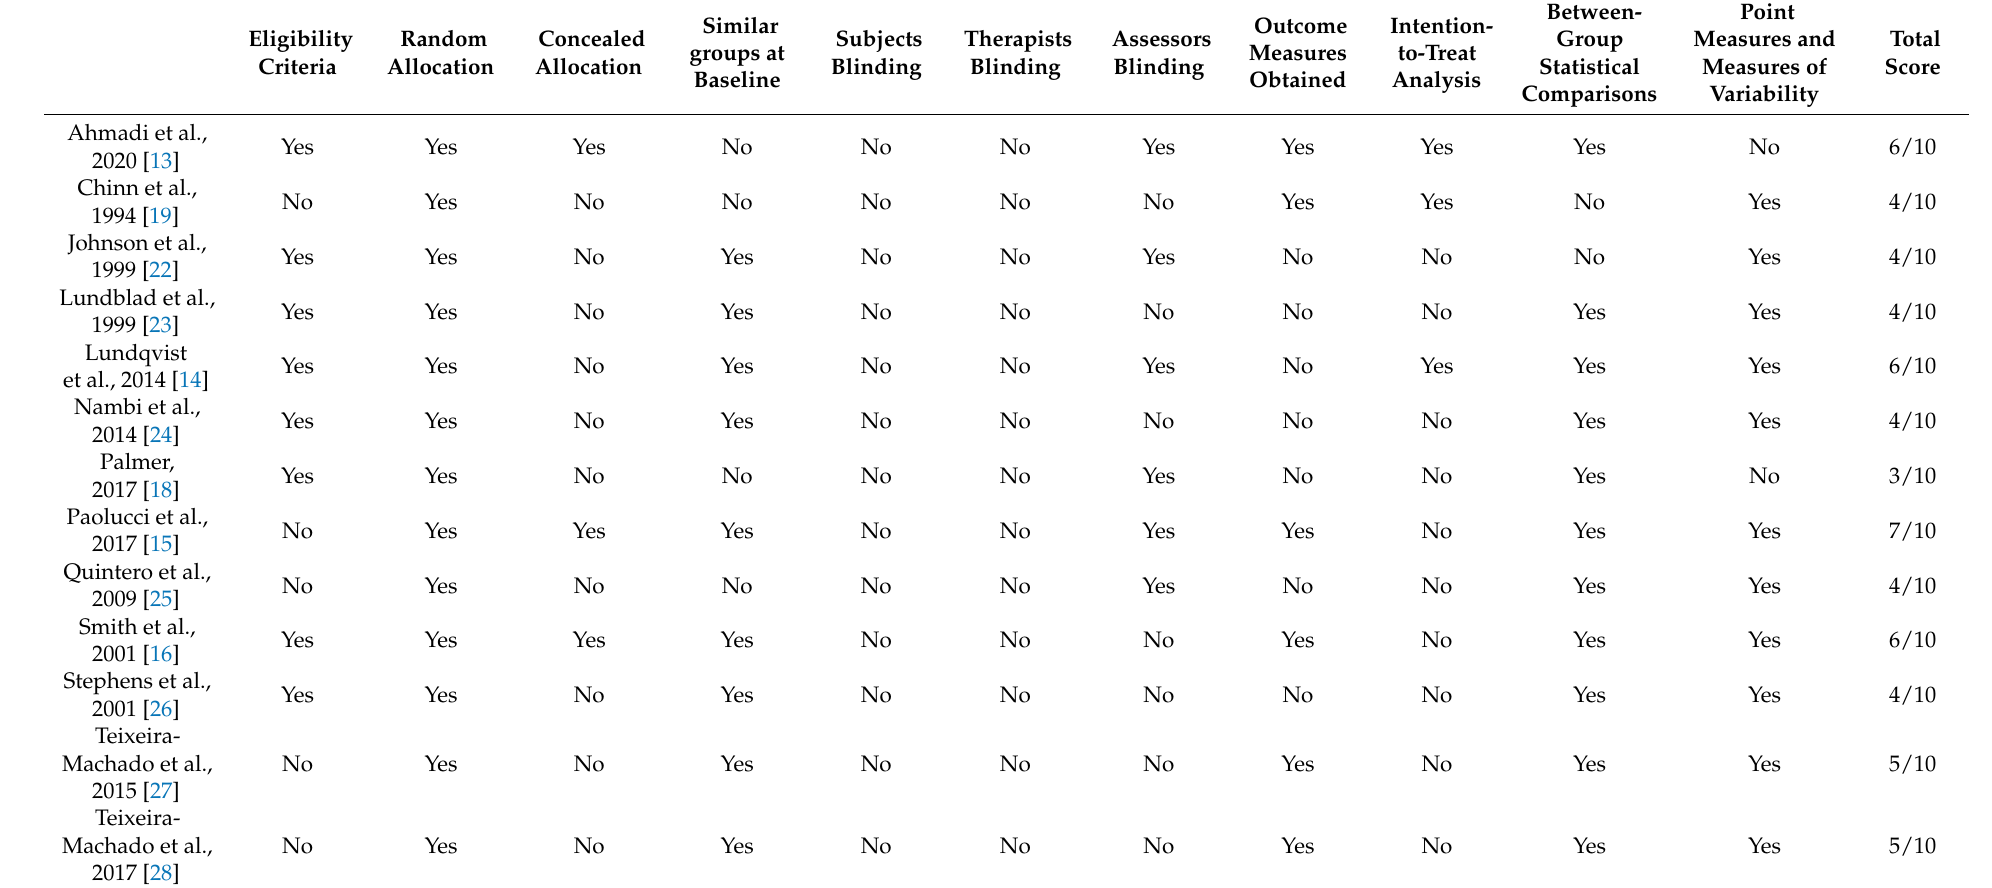
Table 1. Methodological quality of the included articles assessed by using the PEDro